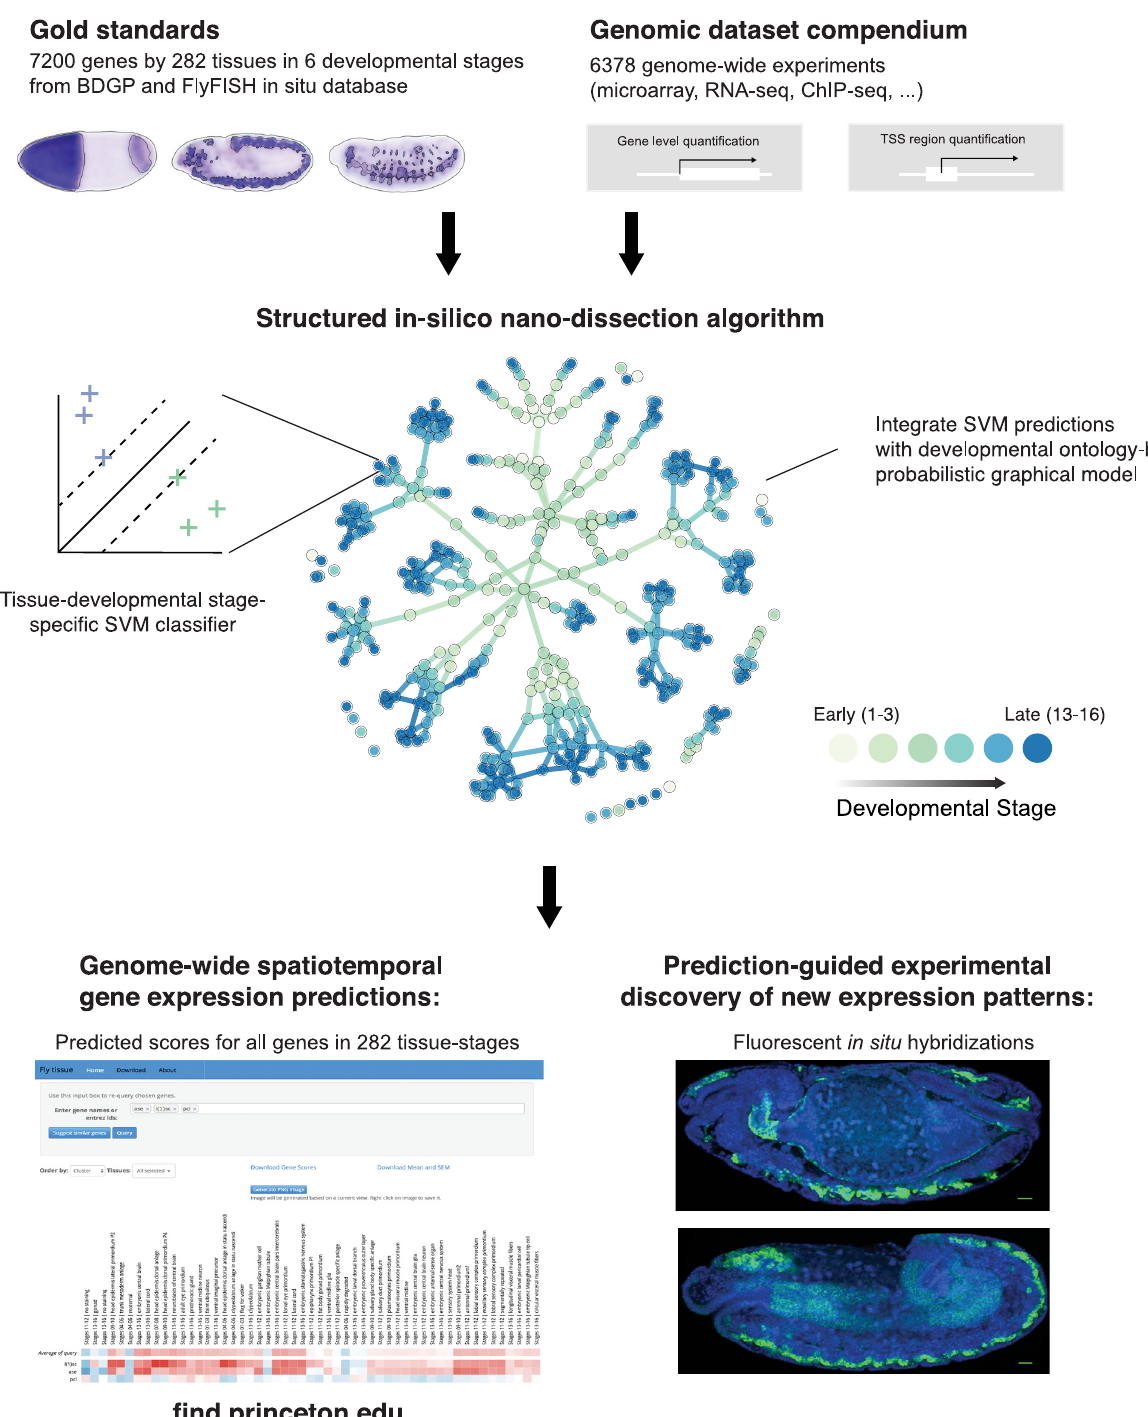
Fig 1. Schematic overview of Drosophila melanogaster spatial-temporal gene expression prediction and validation strategy. The abundance and diversity of high-throughput genomic data, and the spatio-developmental specificity of large-scale in situ experiments allow us to train machine learning models that predict gene expression spatial-temporal specificity in a genome-wide scale. We developed a developmental cell lineage-aware machine learning algorithm, structured in silico nano-dissection (SIND), for this task. First, we trained an array of SVM-perf classifiers for all tissue- stage categories. We then integrated and improved predictions for each category by utilizing tissue-stage relationships with a conditional random field model based on tissue developmental ontology. The validation of predictions was done with prior literature, hold-out in situ data, and new in situ experiments. We verified the spatio-developmental expression pattern of a number of proteins without prior knowledge on expression specificity.